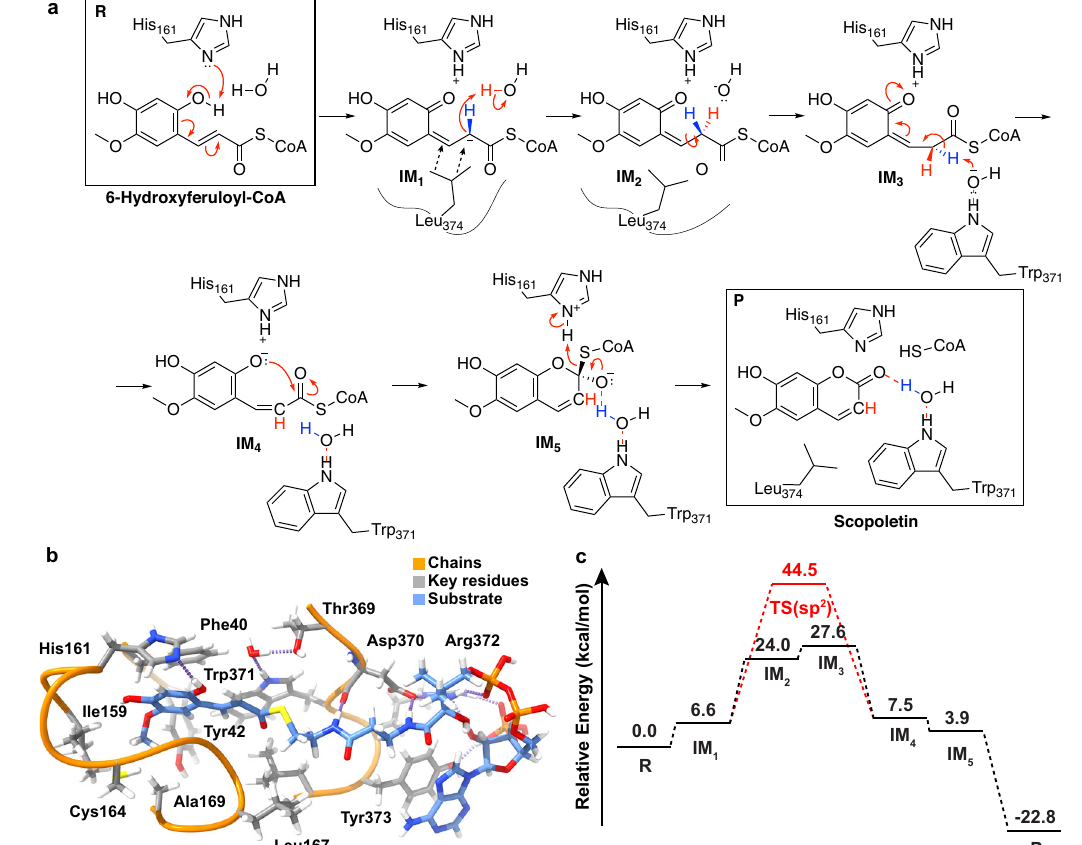
Fig. 4 | Computational insights into the proposed intermediates and reaction energetics of COSY-catalyzed coumarin synthesis. a A schematic of the pro- posedstepwisemechanismofCOSY-catalyzedcoumarinsynthesisfrom6OHFCoA. The reaction begins with deprotonation of the 6-OH of 6OHFCoA by His161, fol- lowed by delocalization of electrons through the conjugated double bond system involving C2 of 6OHFCoA. Then, Leu374 helps orient IM 1 towards the catalytic watermolecule throughvander Waals force, leadingto the additionof a proton at C2. The C2-C3 bond then undergoes isomerization from the s-trans to the s-cis con fi guration.Followingisomerization,lactonizationandreleaseofCoAleadtothe generationofscopoletin.TheoxyanionofIM 5 isdepictedtobestabilizedbyawater